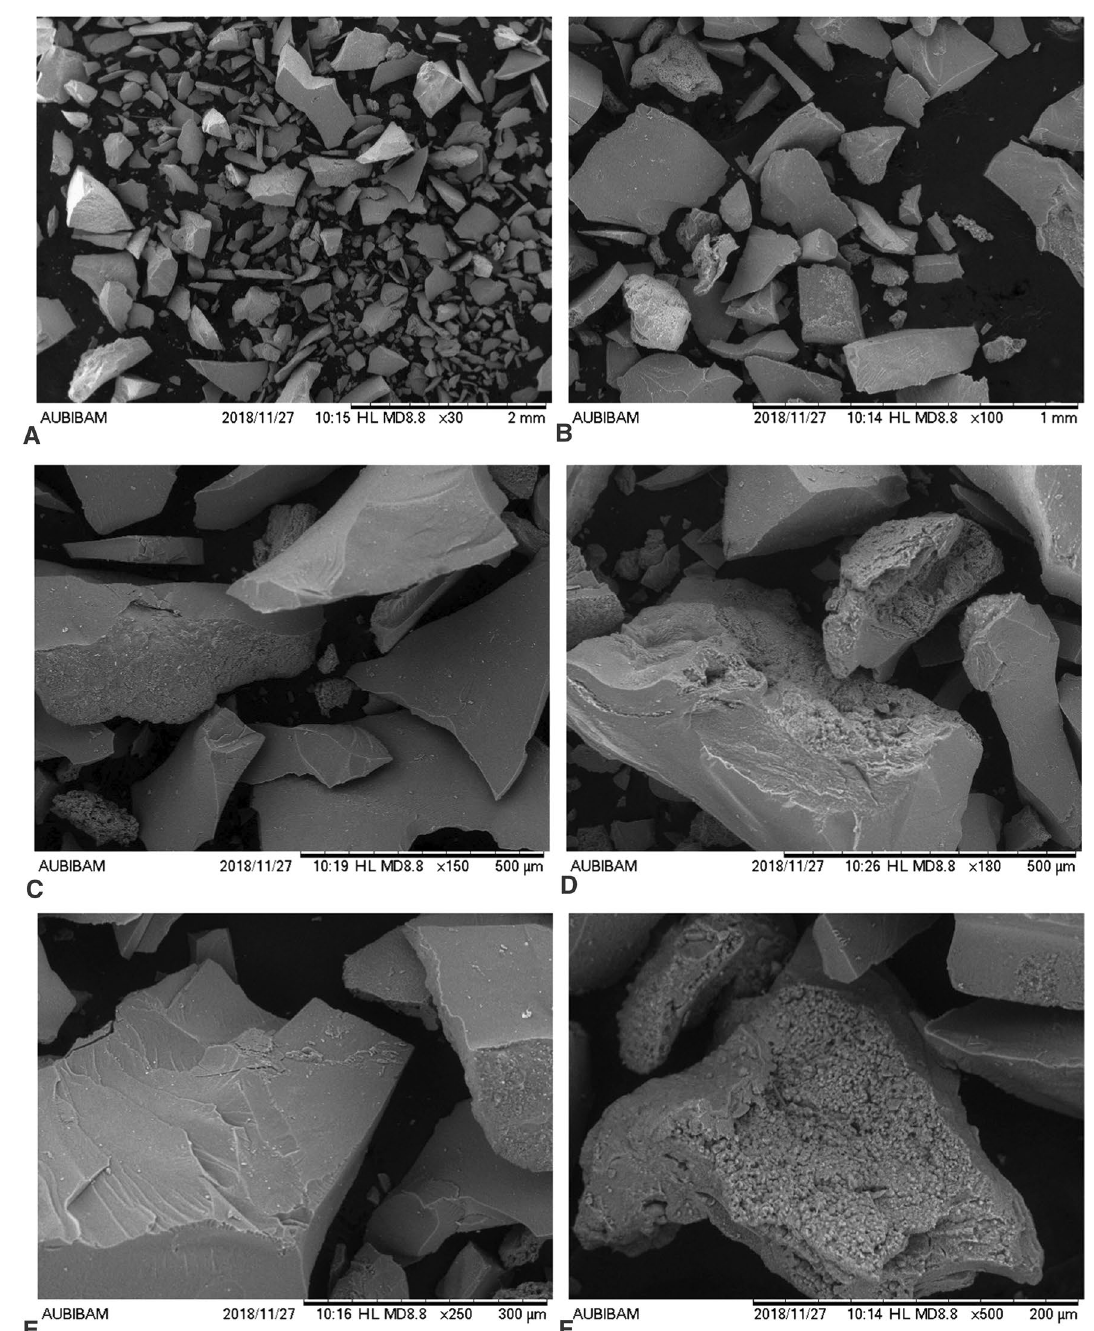
Fig. 9 SEM images of resultant sludge produced in the